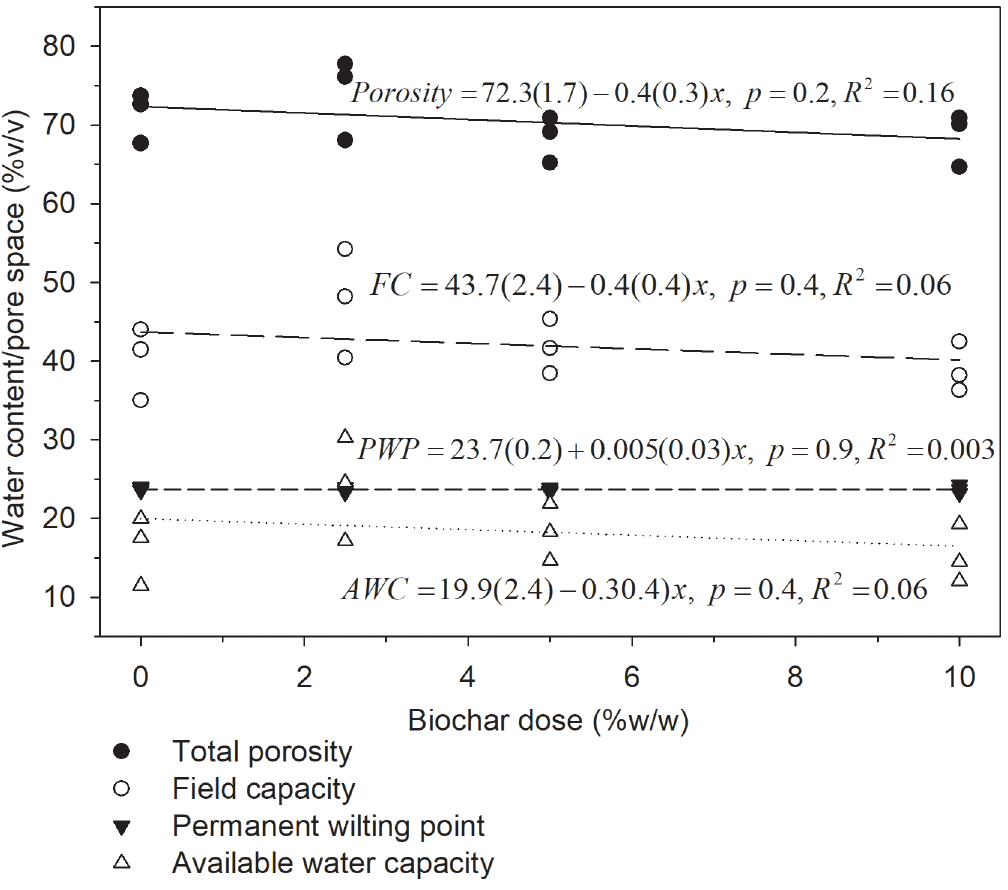
Fig 4. Total porosity, field capacity, permanent wilting point and available water capacity as a function of BC dose, n = 3. The soil is from plough layer of heavy clay in West Timor,